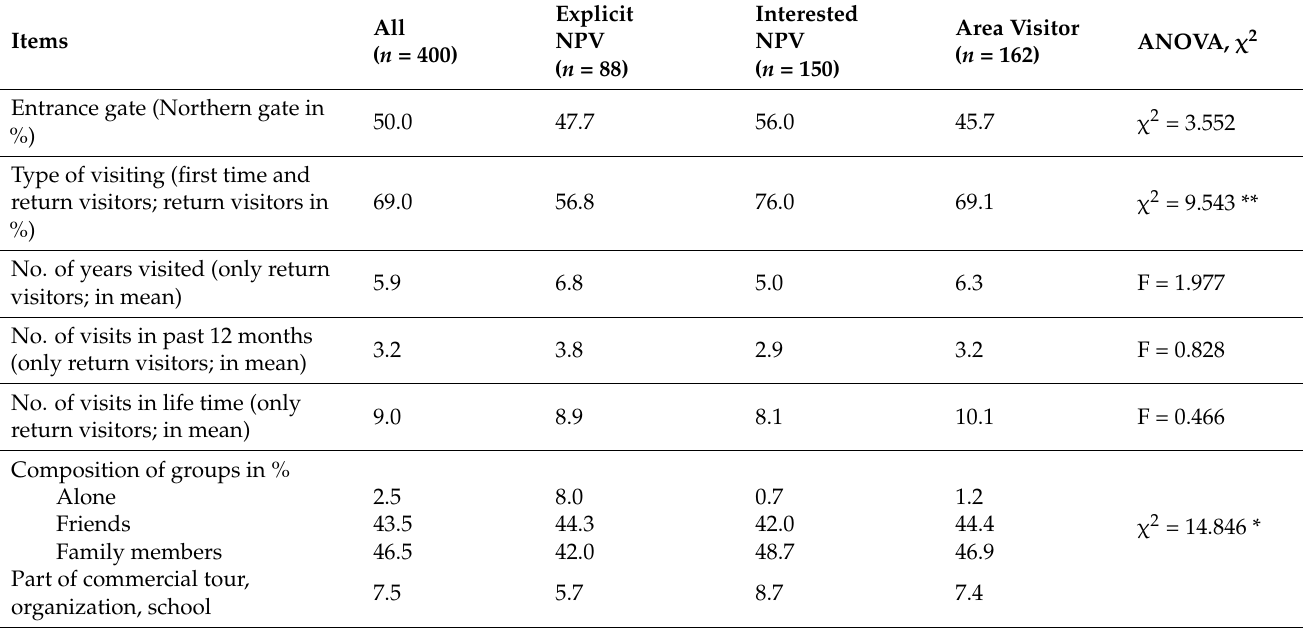
Table 3. Park visit-related profile of respondents and per affinity segment ( n =